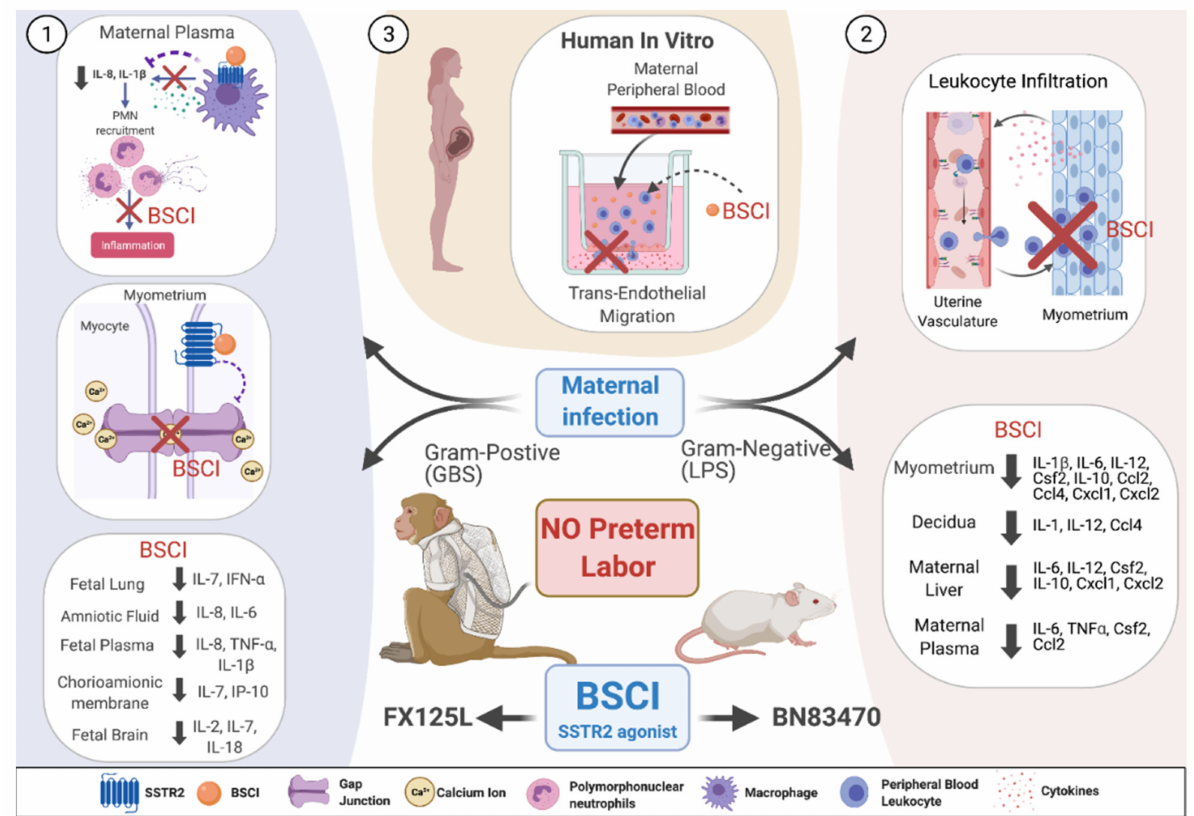
Figure 2. Conceptual model showing BSCI actions in vivo and in vitro as a preterm labor therapeutic. ( 1 ) In vivo adminis- tration of BSCI (FX125L) using a nonhuman primate model of preterm labor induced by Group B Streptococcus (GBS) led to the powerful suppression of uterine activity and a complete blockade of PTB. BSCI treatment led to reduced maternal plasma IL-8 and IL-1 β inhibited myometrial gap junction protein connexin 43 mRNA levels and reduced pro-inflammatory cytokines in amniotic fluid, chorioamniotic membrane, fetal plasma, lungs, and brain compared to GBS alone [210]. ( 2 ) Pro- phylactic in vivo administration of BSCI (BN83470) decreased LPS-induced PTB in pregnant mice, significantly inhibited neutrophil infiltration in the mouse myometrium, and significantly attenuated multiple cytokine/chemokine expression in maternal tissues (myometrium, decidua, plasma, and liver) [211]. ( 3 ) We hypothesize that pre-treatment with BSCI (FX125L) of human primary leukocytes isolated from peripheral blood of pregnant people will also prevent the in vitro trans-endothelial migration of neutrophils towards media containing multiple cytokines secreted from the pregnant human decidua and myometrium. Note: this figure was created with